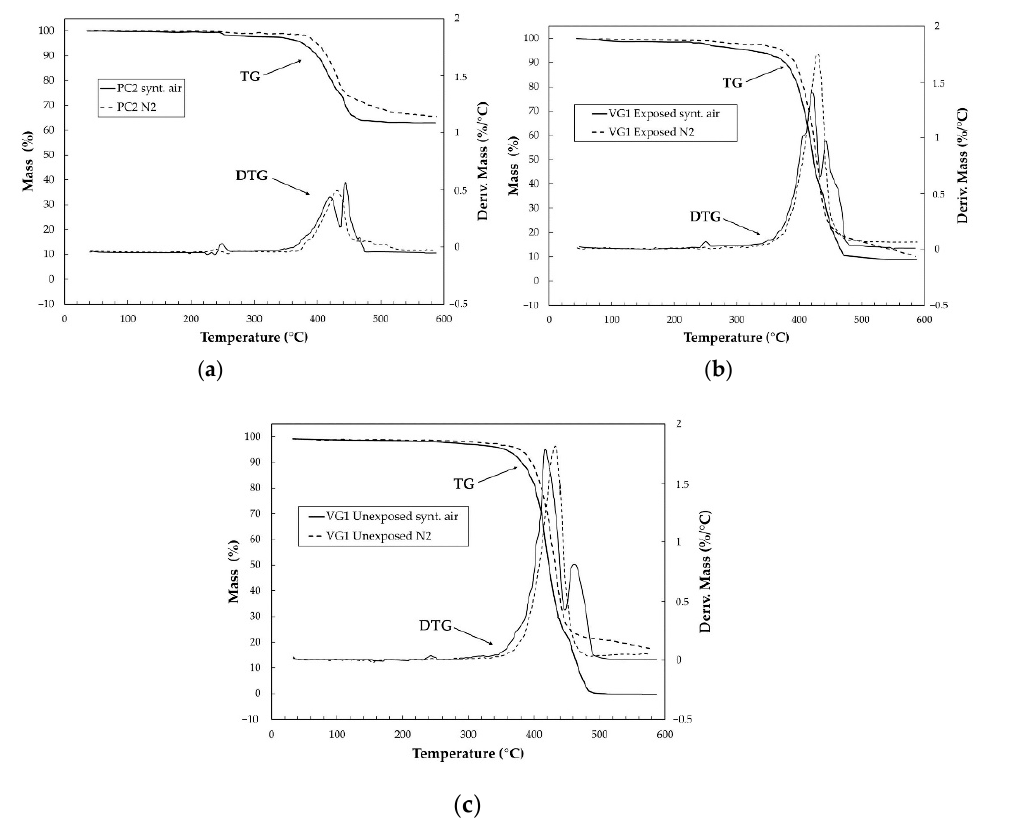
Figure 7. TG/DTG curves for: ( a ) unexposed sample of PC1 section, ( b ) exposed sample of VG1 section and ( c ) unexposed sample of VG1 section. The analyses were carried out under synthetic air and nitrogen gas purge, with mass samples around 3.5 mg (all analyses were conducted with a heating rate of 10 ◦ C min − 1 with flow of 110 mL min − 1 in α -alumina